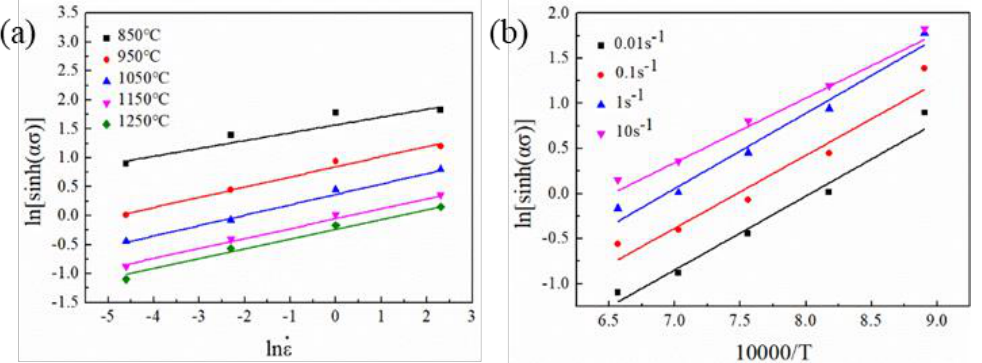
. ε and ( b ) ln[sinh( ασ )]–10,000 /